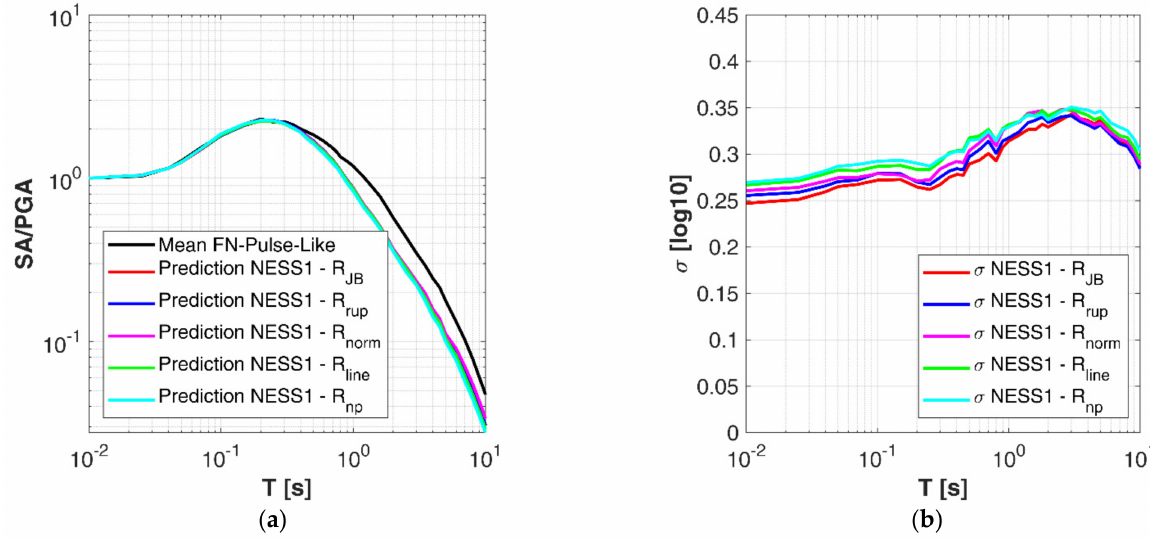
Figure 6. Mean 5% damped acceleration spectra divided by PGA as predicted by the reference ground-motion model (GMM) ( a ) and related mean standard deviation σ ( b ) in log-log scale, for different distance metrics.